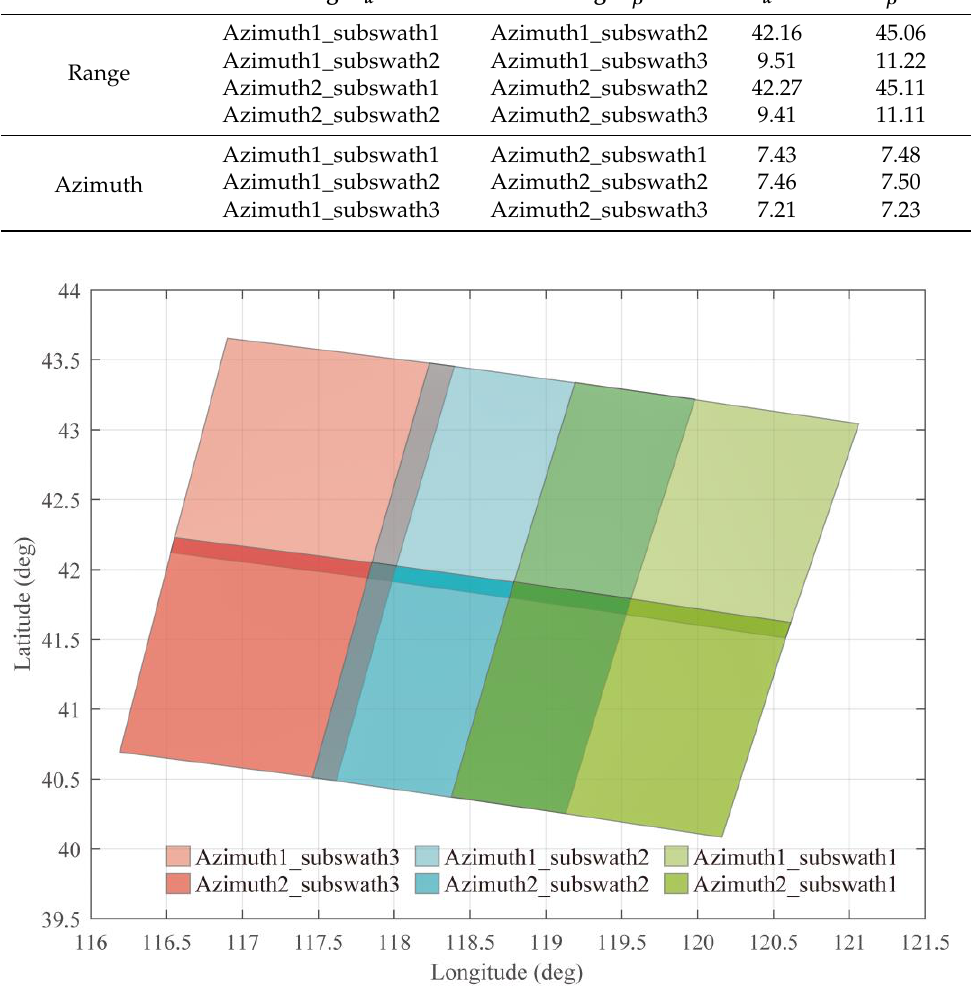
Figure 10. Overlapping areas of the six